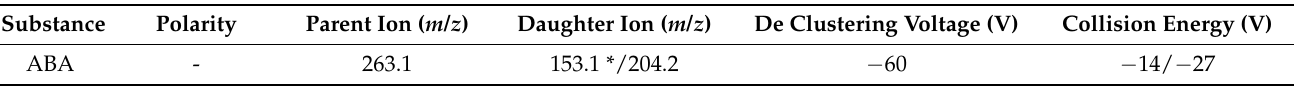
Table 3. Selected reaction monitoring conditions for protonated or deprotonated plant hormones ([M+H] + or [M − H] −